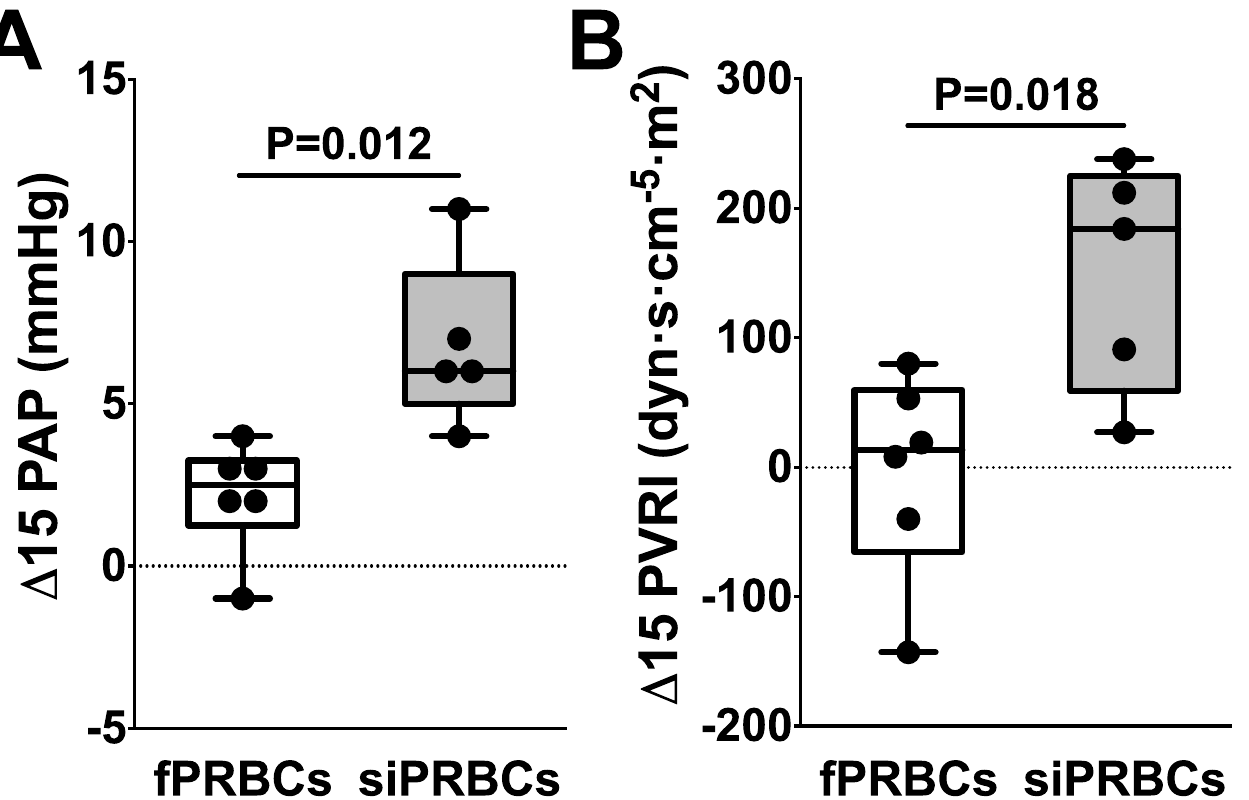
Fig 2. Changes in pulmonary arterial pressure and pulmonary vascular resistance index at 15 minutes after initiation of transfusion. Change in (A) pulmonary arterial pressure ( Δ PAP) and (B) pulmonary vascular resistance index ( Δ PRVI) at 15 minutes after initiation of transfusion in patients receiving fresh packed red blood cells (fresh PRBCs, white bars) or standard-issue packed red blood cells (standard-issue PRBCs, grey bars). Black dots represent respective changes in individual patients. P-values indicate differences among patients receiving fresh PRBCs and standard-issue PRBCs.